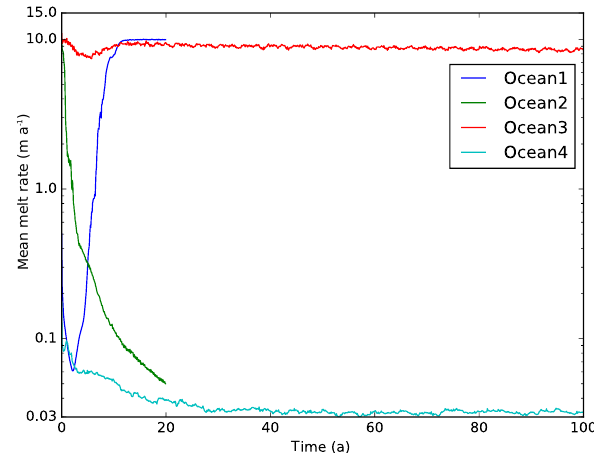
Figure 7. Example results from POP2x simulations showing melt rates averaged over the shelf area as functions of time for Ocean1–4. Melting increases by nearly 2 orders of magnitude in Ocean1, and decreases by about the same order in Ocean2, demonstrating that changes in far-field forcing can greatly increase or reduce melting. After a decade or two of initial adjustment, the melt rates in Ocean3 and Ocean4 remain relatively steady in time despite the changing topography in those experiments, suggesting that the total cavity size has relatively little impact on total